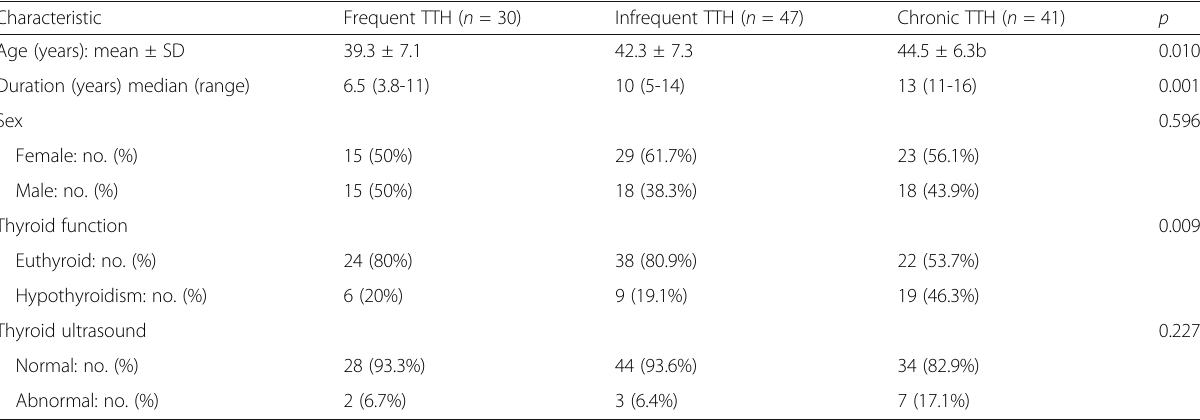
Table 5 Intragroup analysis between tension headache subtypes